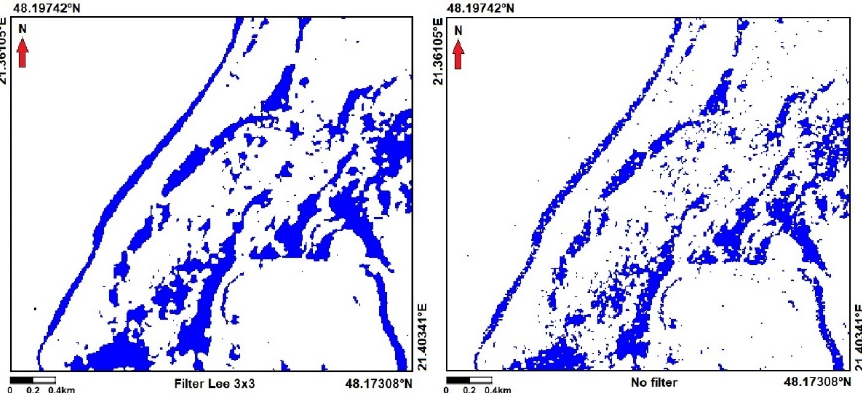
Figure 8. The comparison of water masks after application of 3 × 3 Lee filter and without it.